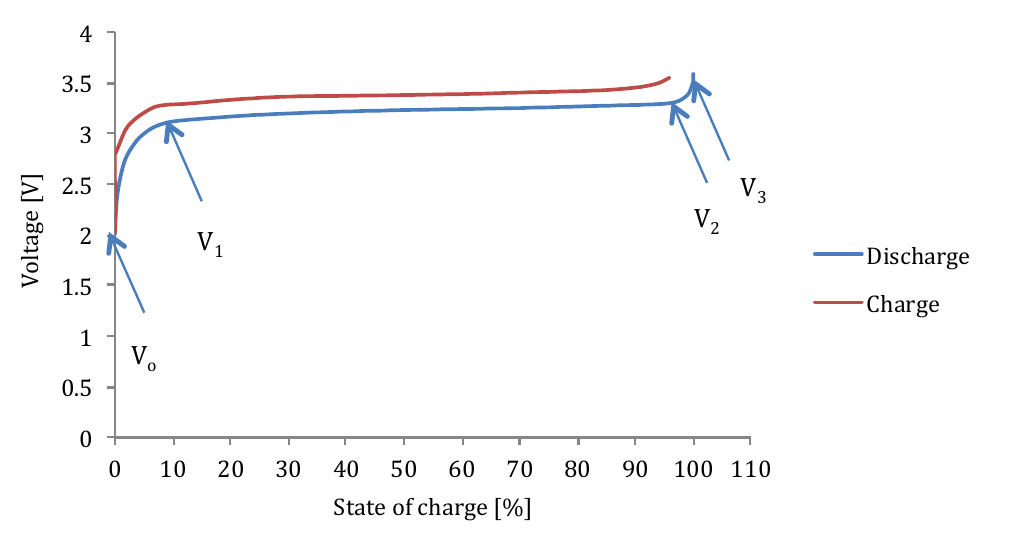
Figure 19. Hysteresis lithium-ion battery brand